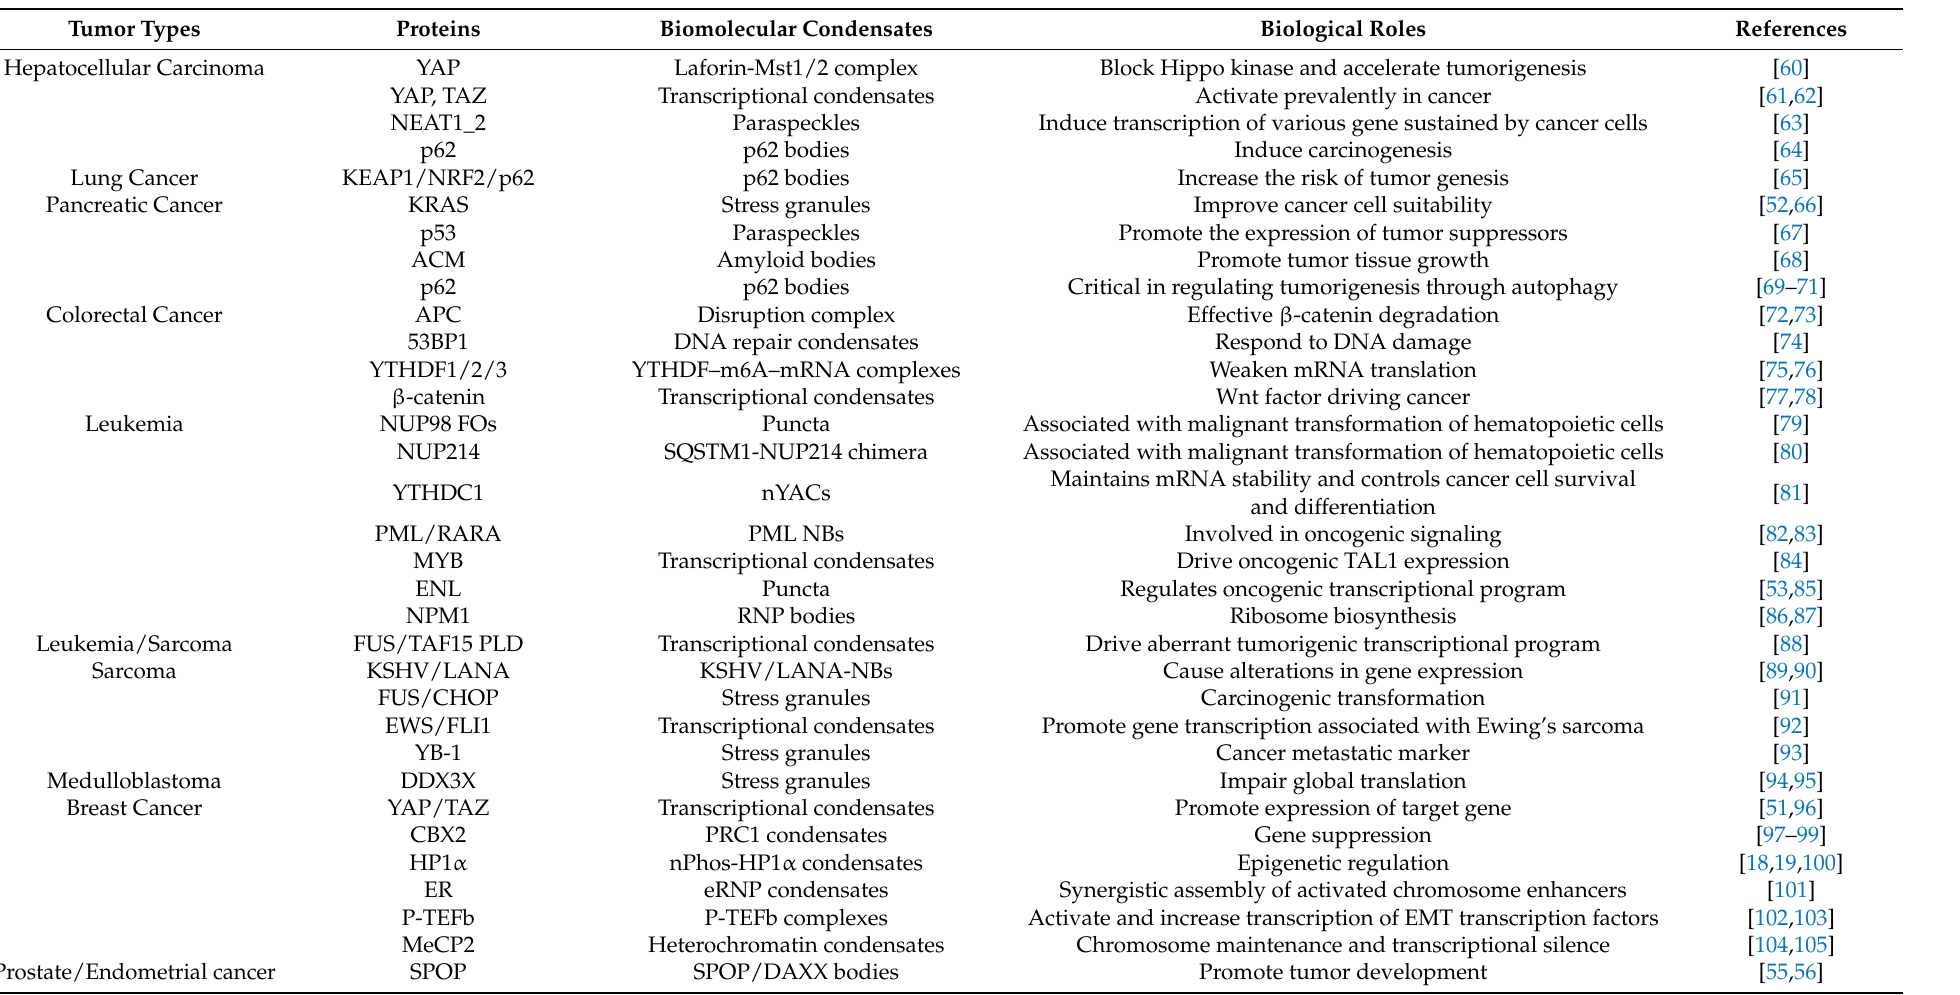
Table 1. Condensates in cancer. Abnormal protein phase separations are involved in the progression of various